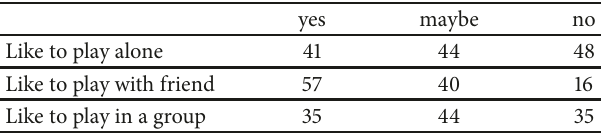
Table 4: Rating of whether the player would prefer to play alone, with a friend or in a group.